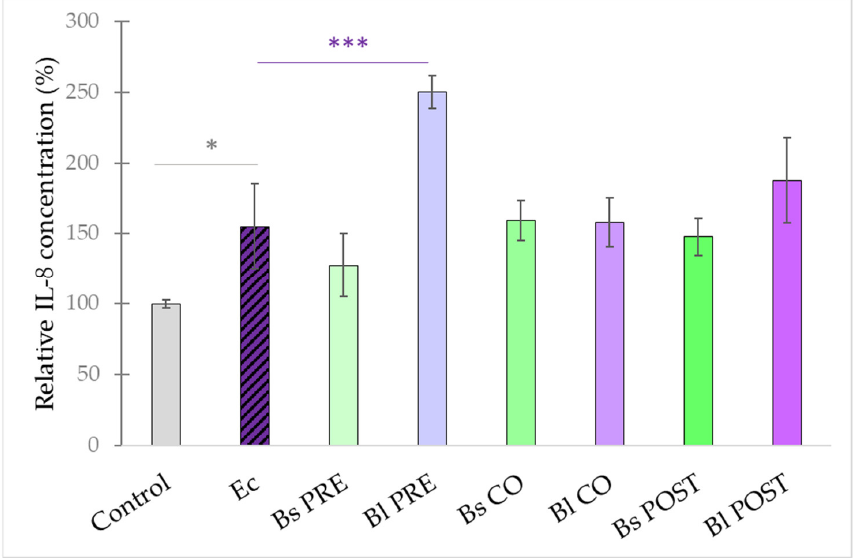
Figure 7. Induction of IL-8 secretion of IPEC-J2 cells after stimulation with E. coli , B. licheniformis, and B. subtilis . B. licheniformis and B. subtilis were added 1 h before (pre-treatment), at the same time as (co-treatment), or 1 h after (post-treatment) the addition of E. coli . B. licheniformis and B. subtilis were added in 10 8 CFU/mL and E. coli was added in 10 6 CFU/mL concentration. Control : plain cell culture medium treatment; Ec : E. coli 10 6 CFU/mL; Bs PRE : pre-treatment with B. subtilis 10 8 CFU/mL + E. coli 10 6 CFU/mL; Bl PRE : pre-treatment with B. licheniformis 10 8 CFU/mL + E. coli 10 6 CFU/mL; Bs CO : co-treatment with B. subtilis 10 8 CFU/mL + E. coli 10 6 CFU/mL; Bl CO : co-treatment with B. licheniformis 10 8 CFU/mL + E. coli 10 6 CFU/mL; Bs POST : post-treatment with B. subtilis 10 8 CFU/mL + E. coli 10 6 CFU/mL; Bl POST : post-treatment with B. licheniformis 10 8 CFU/mL + E. coli 10 6 CFU/mL. Data are shown as means with standard deviations and expressed as relative IL-8 concentration, considering the mean value of control as 100%. n = 6/group. Significant difference: * p ≤ 0.05, in grey: compared with the untreated control. *** p ≤ 0.0001, in purple: compared with treatment with E. coli . 3.3. Effect of Bacillus subtilis and Bacillus licheniformis on the Intracellular Redox State of IPEC-J2 Cells Challenged by Salmonella Typhimurium and Escherichia coli In order to characterize the intracellular redox state of the IPEC-J2 cells, the DCFH- DA method was used. Treatment with S. Typhimurium caused an increase in the fluores- cence compared with the control (Figure 8). Treatment with B. subtilis alone significantly decreased the fluorescence compared with the control; however, when IPEC-J2 cells were treated with only B. licheniformis , no significant effect compared with the control could be observed. Pre-, co-, and post-treatment with both probiotic bacteria resulted in a de- creased amount of ROS compared with ROS production induced by S. Typhimurium.